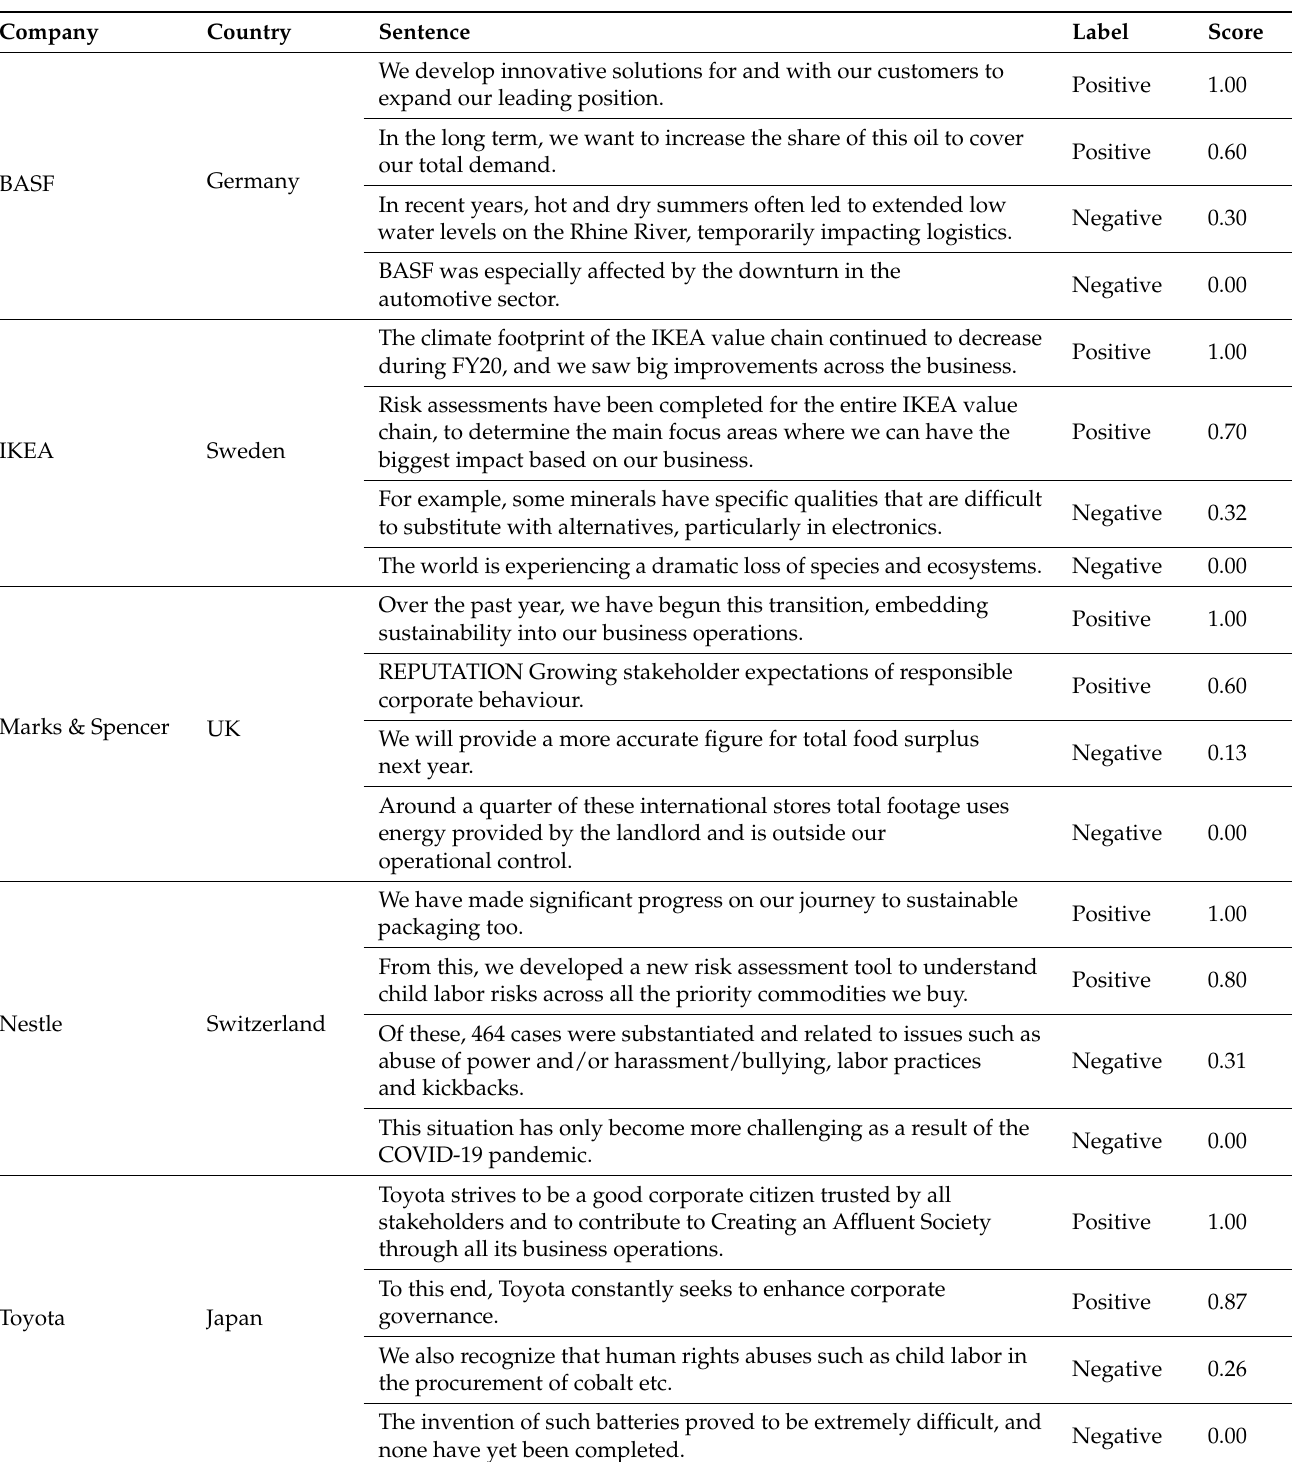
Table 5. Examples of sentiment analysis from each company’s 2020 sustainability